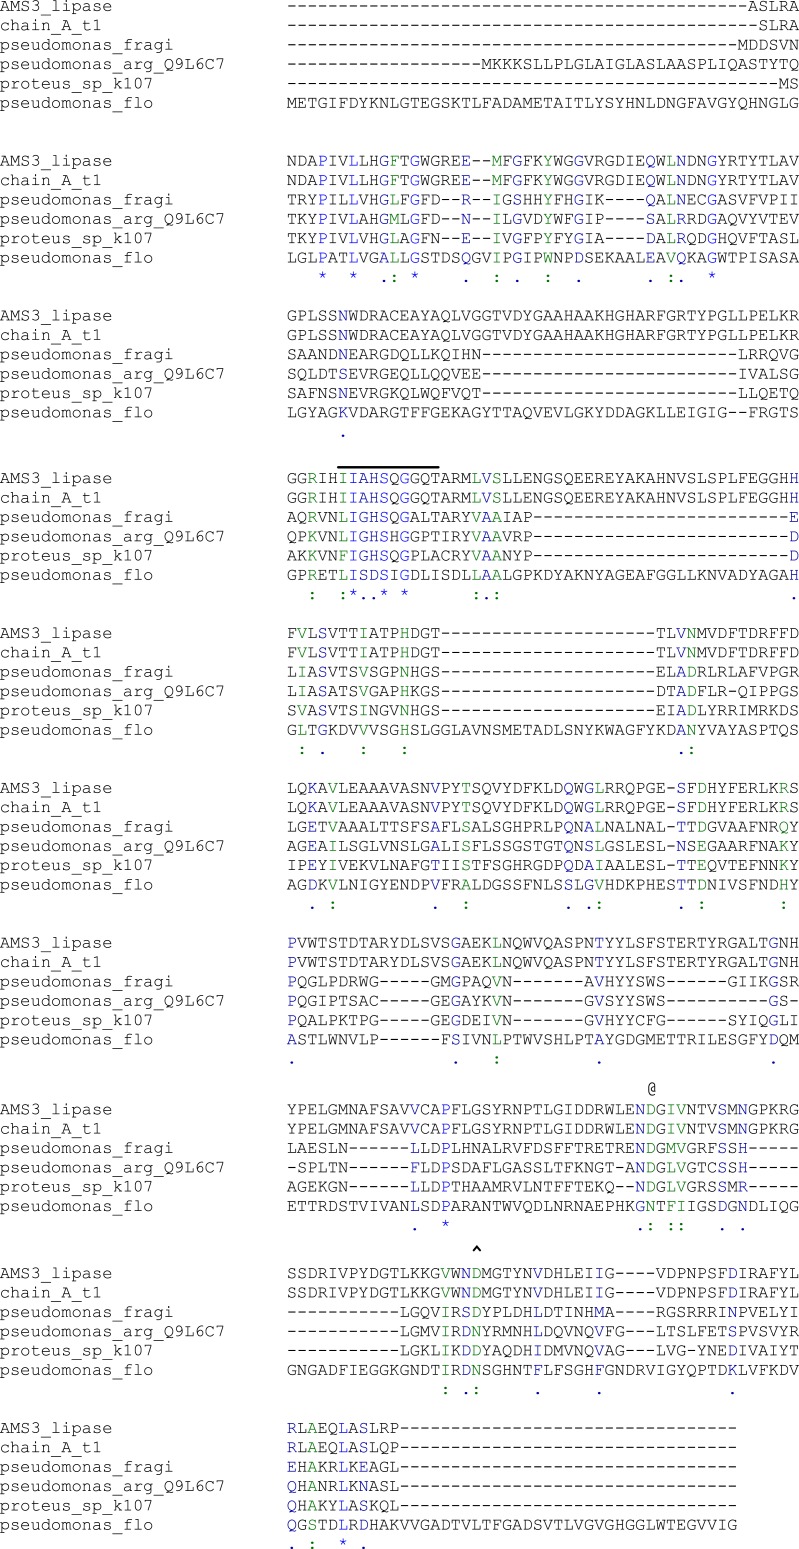
Alignment of the AMS3 lipase sequence with Pseudomonas lipases of known three-dimensional structure.The AMS3 was aligned with P. aeruginosa lipase (Q9L6C7), P. fragi lipase (AY787823), G. bacillus T1 (AY166603) and Proteus sp. K107. −, Serine Pentapeptide; @, Aspartic acid; and , \documentclass[12pt]{minimal}
\usepackage{amsmath}
\usepackage{wasysym} 
\usepackage{amsfonts} 
\usepackage{amssymb} 
\usepackage{amsbsy}
\usepackage{upgreek}
\usepackage{mathrsfs}
\setlength{\oddsidemargin}{-69pt}
\begin{document}
}{}$\hat {}$\end{document} ˆ, Amino acid involve in calcium binding. (*) blue: Conserved residue; (:) green: conservation of strong groups; (.) blue: conservation of weak groups.